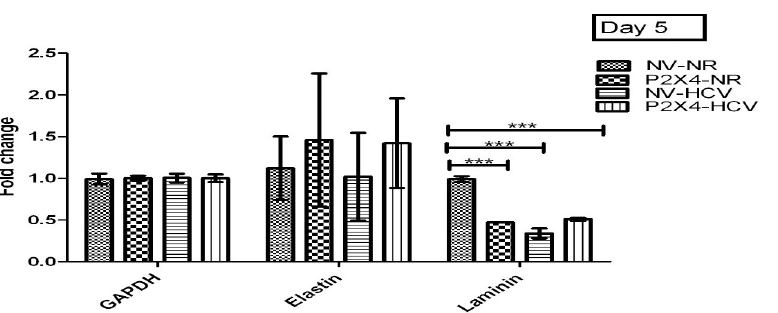
Fig 17. Expression of ECM markers on day 5 of post infection. All values are expressed as mean ± SEM, � P � 0.05 vs. control.